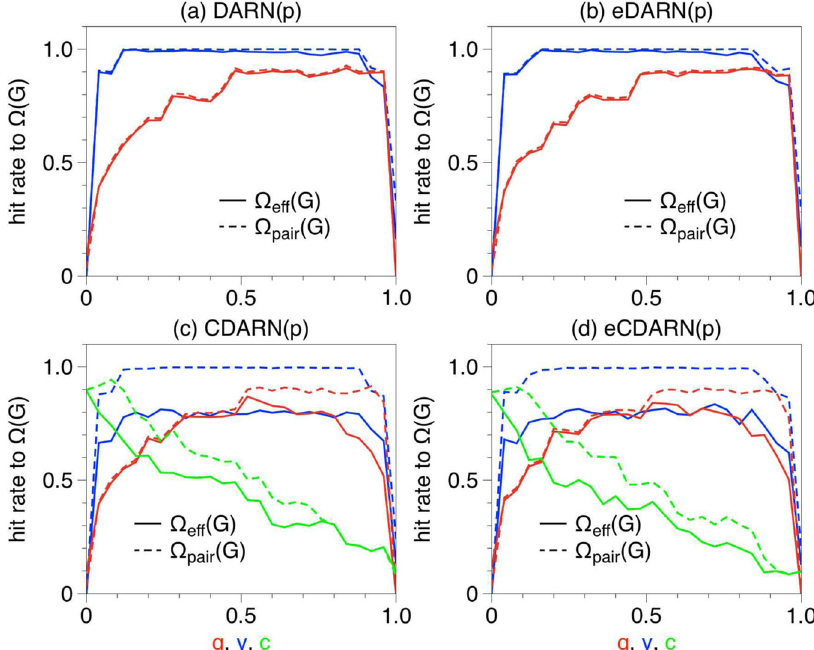
Fig. 3 Hit rates to scalar memory Ω ð G Þ for synthetic models. In each case we compute the percentage of the times within an ensemble of 10 3 realisations that the estimated effective memory Ω eff ð G Þ and estimated pair memory Ω pair ð G Þ exactly match the scalar memory Ω ð G Þ (the memory parameter p is randomly sampled from UNIFORM{1,...,10} for each realisation). Models depend on parameters q , y and (where applicable) c (see SI section IV for details), so each curve scans hit rates for the whole range of a given parameter and fi x the values of the other parameters to q = 0.9, y = 0.1, c = 0.1 (in every case, time series size is T = 10 6 ). In DARN( p ) and eDARN( p ) models (panels a and b ) where virtual loops are by construction absent, Ω their estimation typically coincide with Ω ð G Þ for a large range of model parameters, as expected. In CDARN( p ) and eCDARN( p ) models (panels c and d ), (probabilistic) virtual loops are expected to kick in, inducing a mismatch between Ω quantity disregards diagonal entries of the co-memory matrix and thus cannot account for fi rst-order virtual